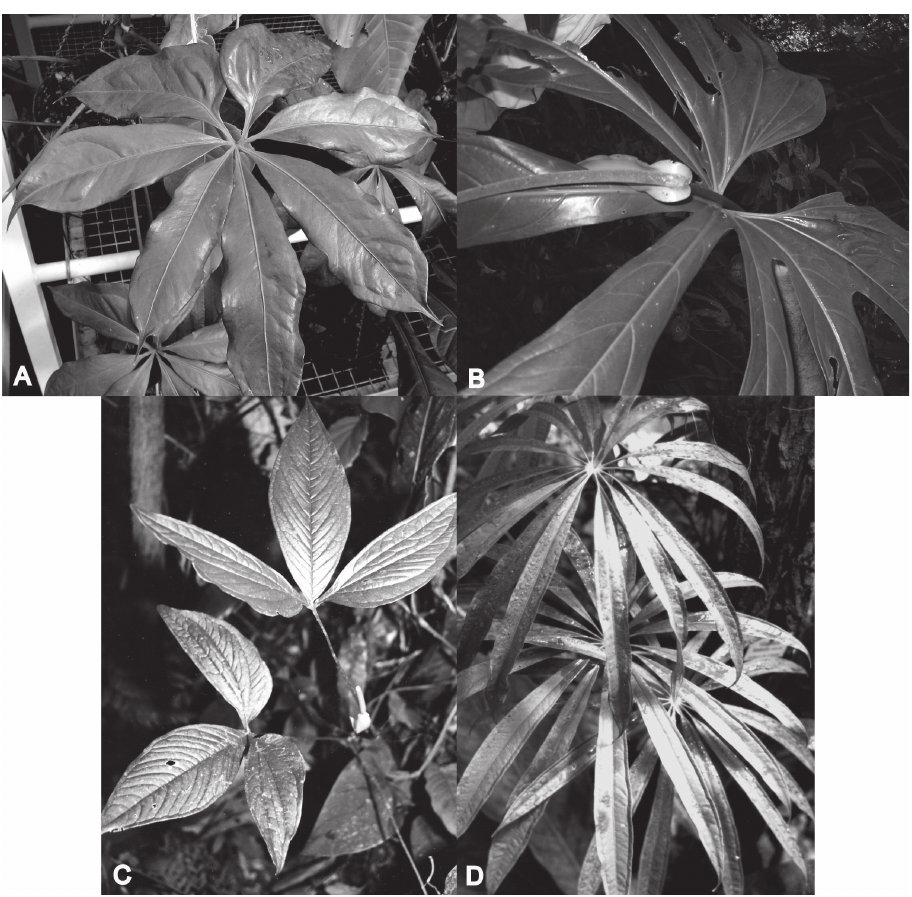
Figure 1. Examples of Anthurium species with palmately divided leaves here included in section Dacty- lophyllium (Schott) Engler emend. Croat & Carlsen. A Palmatisect leaf with seven leaflets of Anthurium pentaphyllum (Aubl.) G.Don var. pentaphyllum ( M. Leppard 1395 ) B Palmatifid leaf of Anthurium longis- simum Pittier ssp. longissimum ( M. Carlsen 2126 ) C Palmatisect leaves with three leaflets of Anthurium trisectum Sodiro ( T.B. Croat 48977 ) D Palmatisect leaves with more than 9 leaflets of Anthurium